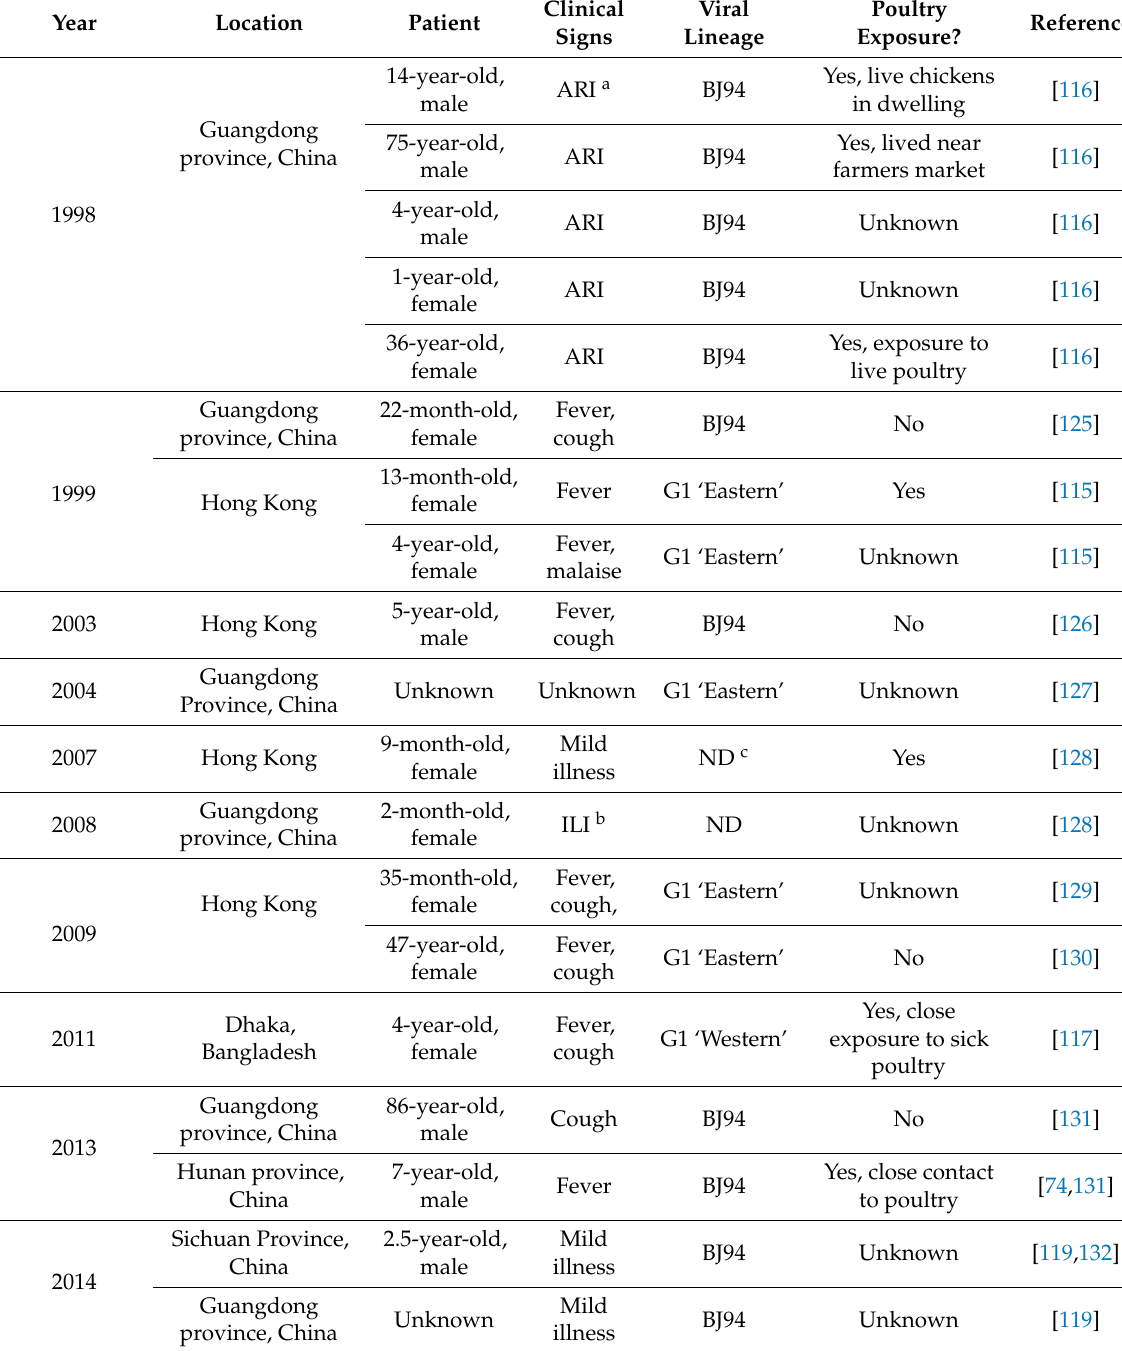
Table 2. Laboratory confirmed human cases of H9N2